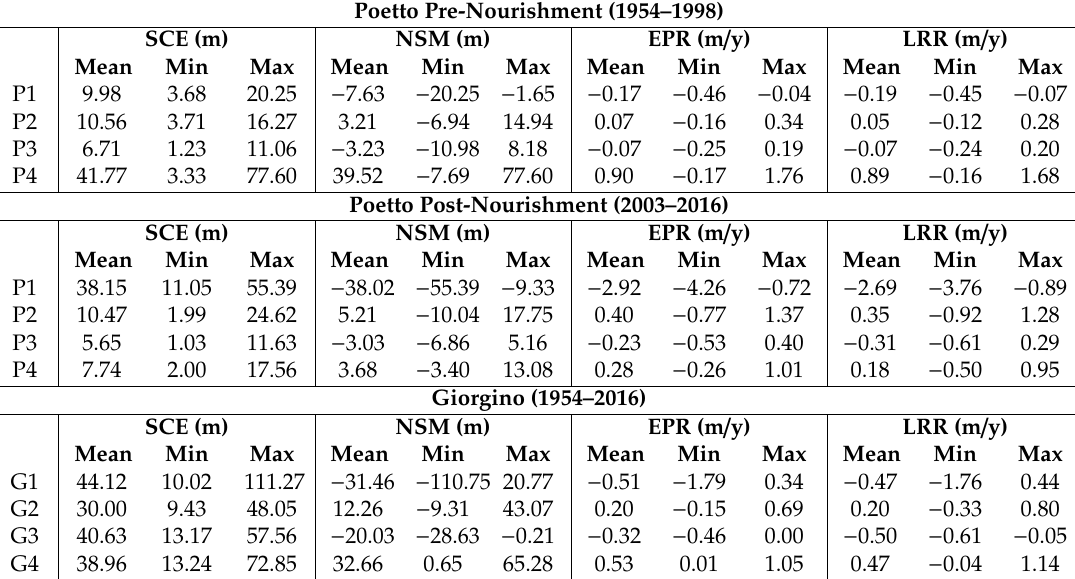
Table 2. Summary of the results showing the calculated mean, min and max values for all of the statistical